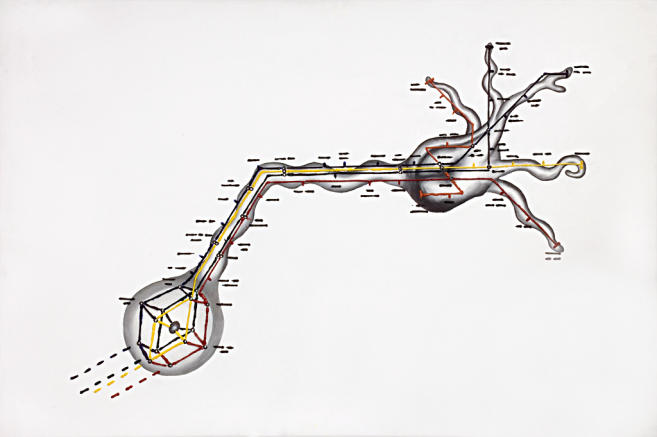
Painting by Alex McCuish (Hills Road Sixth Form College, Cambridge, United Kingdom) illustrating the protein interaction network underlying nerve function